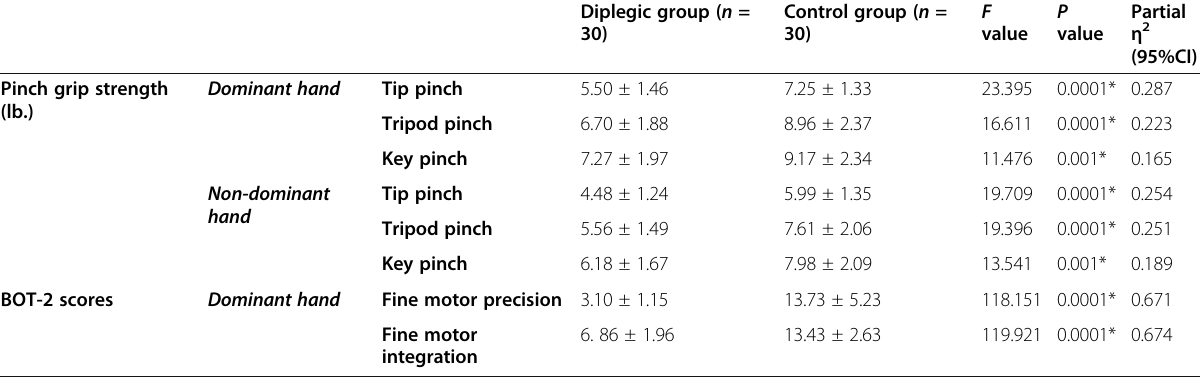
Table 2 Comparison of pinch strength and BOT-2 scores between diplegia and control groups